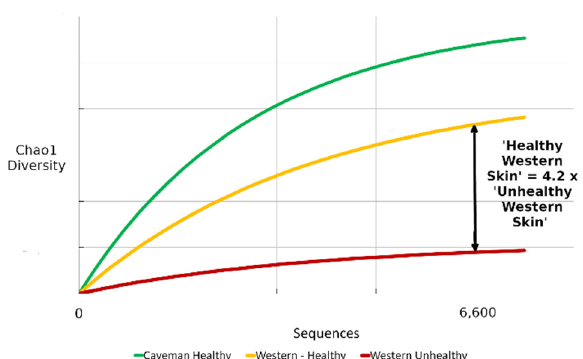
Figure 8. Graph showing the combined benchmarks taken from our previous work [34]. This graph formed the basis for the skin health measuring mechanism, with benchmark values of diversity for a range of different states of health on the skin. For an explanation of each please see our previous work.